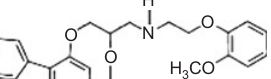
at Pt disk elec- 4